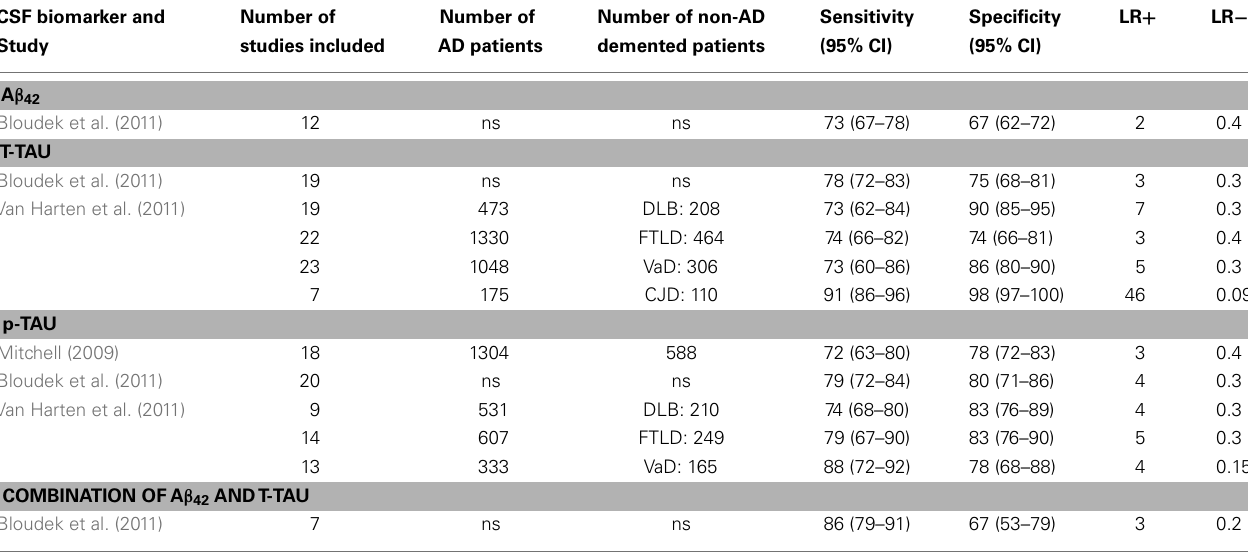
Table 3 | Systematic reviews with meta-analyses (AD vs. other dementias): sensitivity and specificity values. CSF biomarker